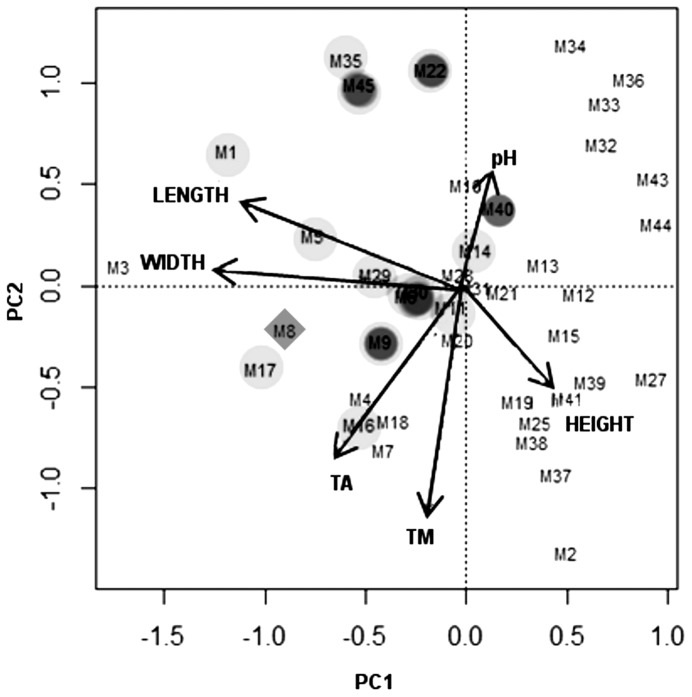
Biplot of PC2 vs PC1 from variables describing bromeliads.Grey circle = B. morio, black circle = B pacaya and black diamond = unidentified (juveniles with no tissue available). Height above ground = Height, ambient temperature = TA, microhabitat temperature = TM, Tank size diameter = width, size along the second leaf of the bromeliad = Length.